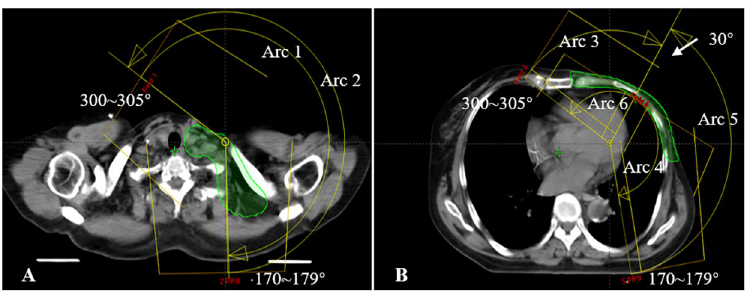
Fig 1. Schematic diagram showing the planning target volume (PTV) and beam arrangements for a representative patient. A, the two continuous ~240˚ arcs that start at 300 ~ 305˚ and stop at 170 ~ 179˚ for lymph nodes in SCF; B, the four split sub-arcs obtained by splitting two ~240˚ arcs at 30˚ for the chest